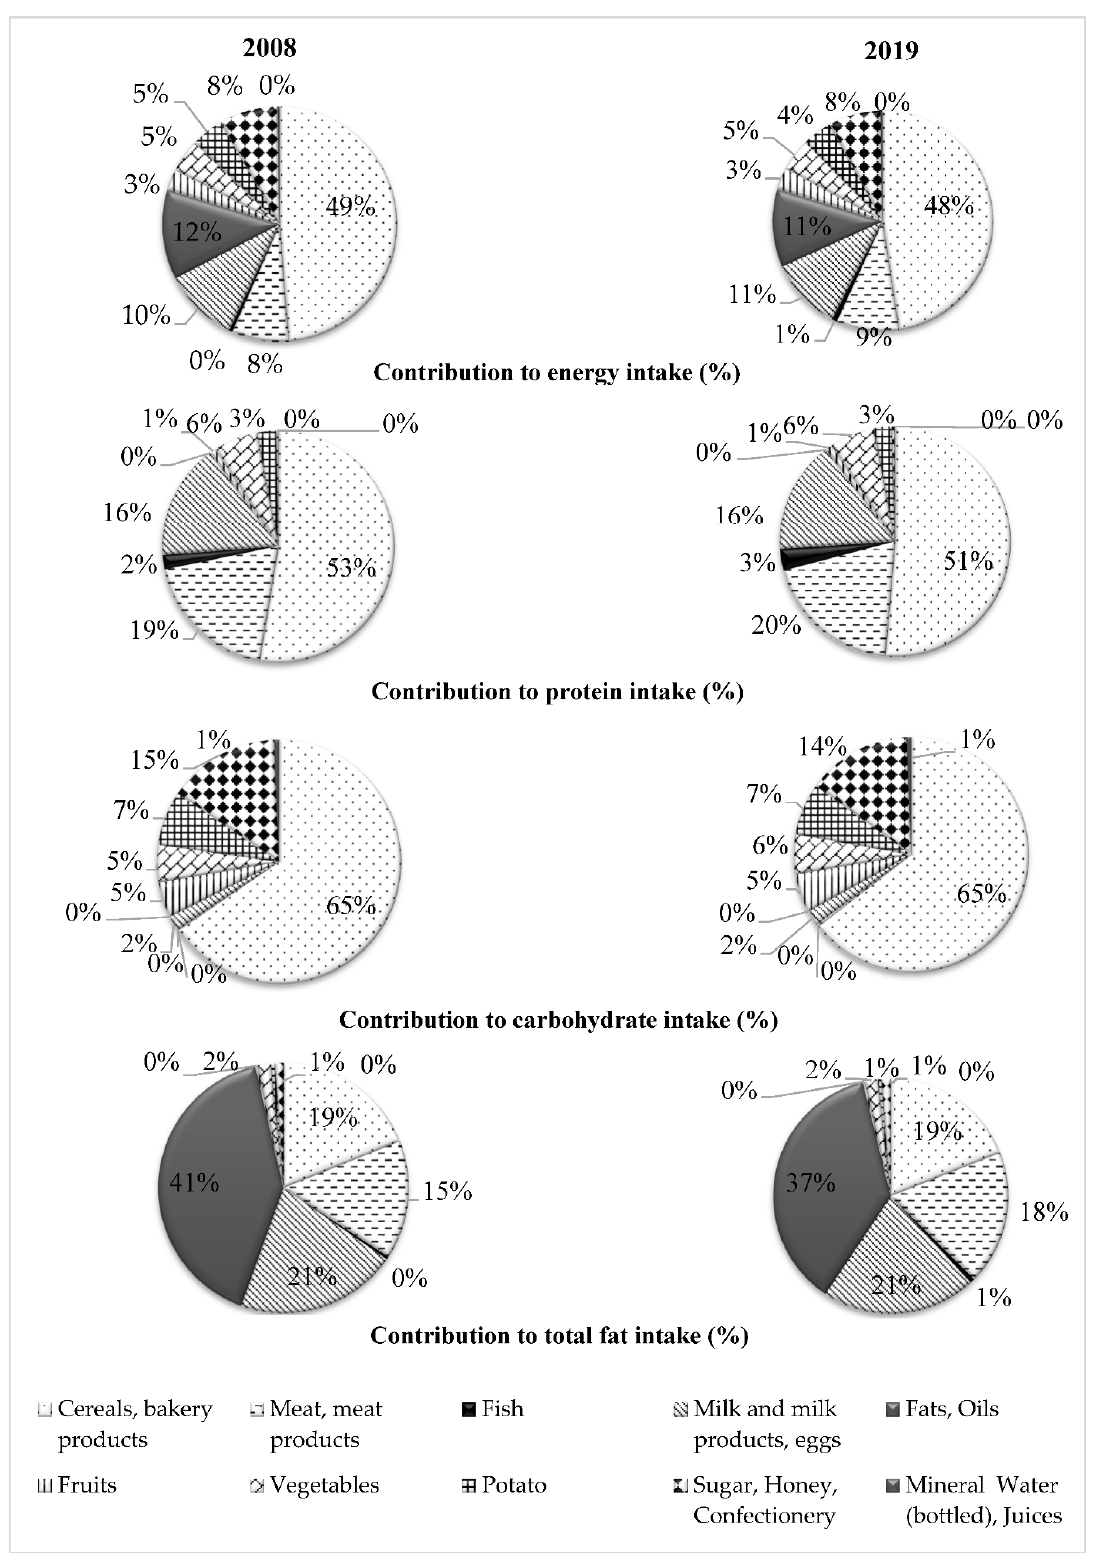
Figure 3. Contribution of food groups to energy and macronutrient intake (%). Armenia. 2008 and 2019.